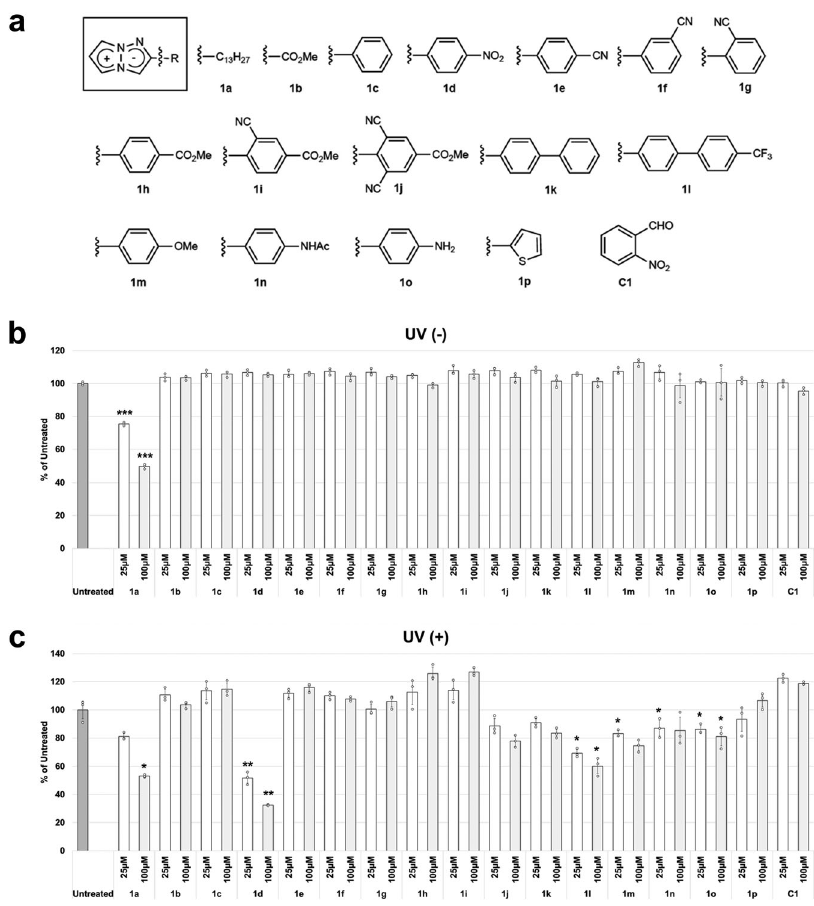
Fig. 2 Screening for 2-substituted TAP derivatives exhibiting photo-induced cytotoxicity. a Structures of TAP derivatives. b HeLa cells were cultured with 25 μ M (black) or 100 μ M (white) of each TAP derivative containing 0.1% DMSO as a control. After 1 h incubation, their cytotoxicities were analyzed by WST8 assay 34 . No cytotoxicity was observed without UV irradiation except for 1a . c HeLa cells were cultured with 25 μ M (black) or 100 μ M (white) of each TAP derivative containing 0.1% DMSO as a control. After 1 h incubation, the cells were irradiated by UV (365 nm) for 1 h, and then their cytotoxicities were analyzed by WST8 assay. Several derivatives showed cytotoxicity under UV irradiation. Especially, p -nitrophenyl analog 1d showed potent cytotoxicity in a concentration-dependent manner ( C1 : Negative control). * P <0.05, ** P <0.01, *** P <0.001 (vs Untreated) (Student ’ s t -test) N = 3 biologically independent samples. The error bars represent the standard deviation of the